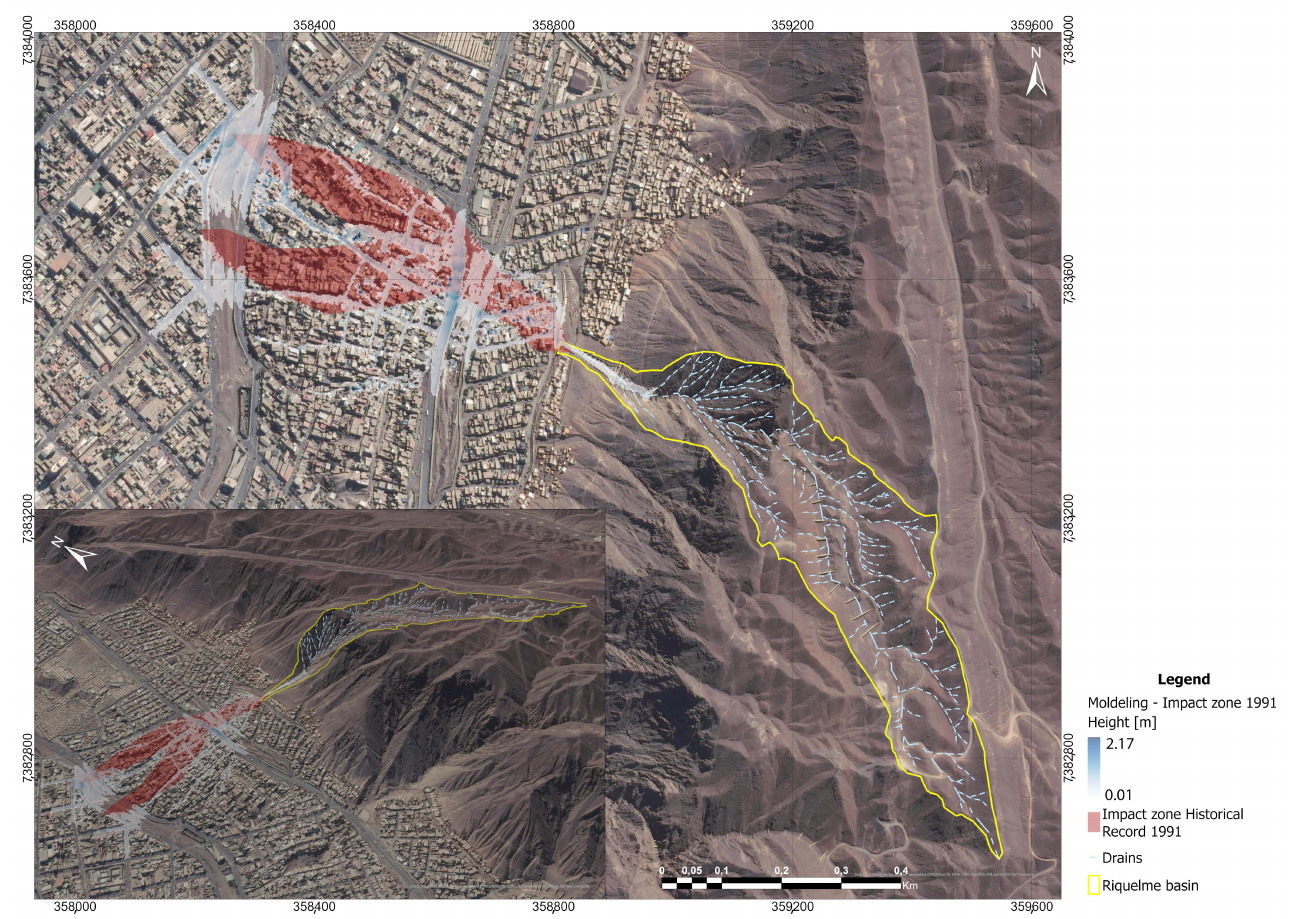
Figure 11. 2D and 3D view of the methodological validation map with application in the Riquelme basin between the historical record of the impact zone due to flow-type landslide of the 1991 hydrom- eteorological event and the mathematical modeling with application of the same methodology of La Chimba basin